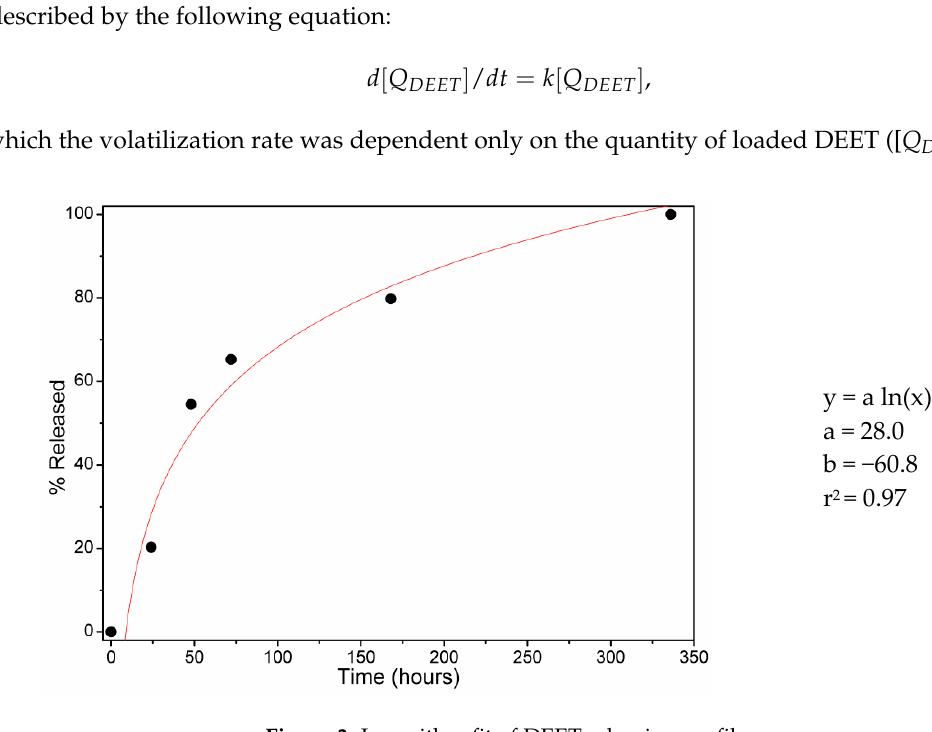
Figure 3. Logarithm fit of DEET releasing profile.